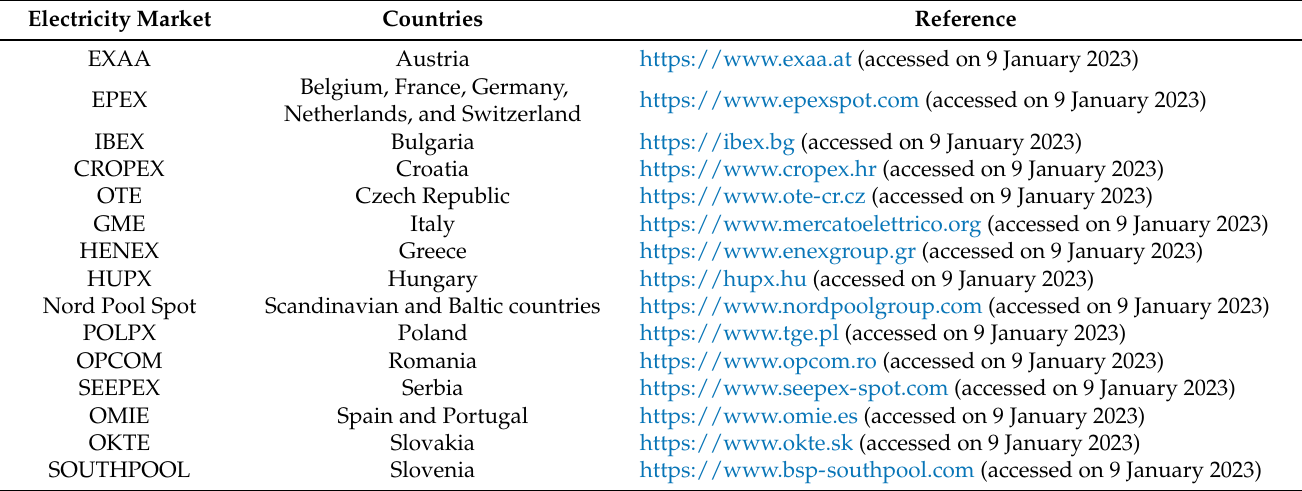
Table 1. European electricity market operators